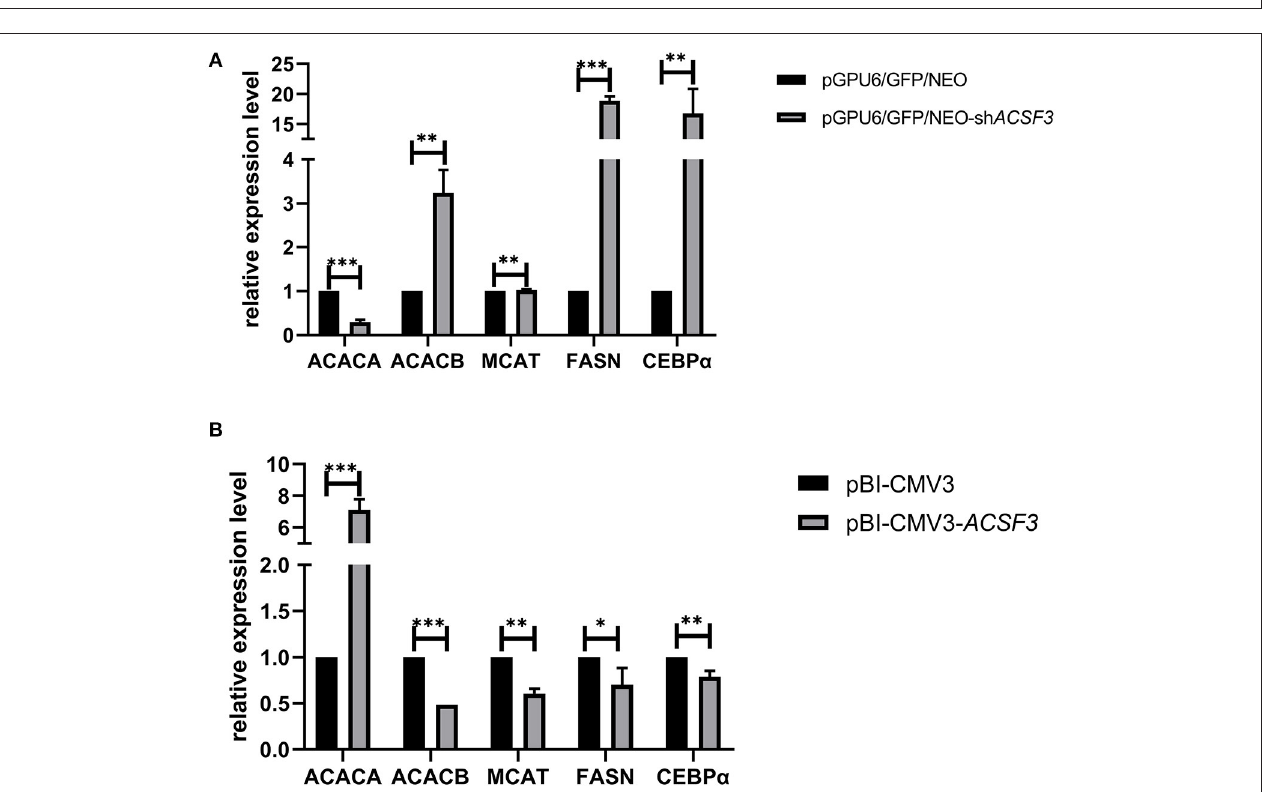
FIGURE 3 | The mRNA expression of lipid metabolism-related genes in BMECs after interference (A) or overexpression of (B) the ACSF3 gene. *** means p < 0.001, ** means p < 0.01, * means p < 0.05.